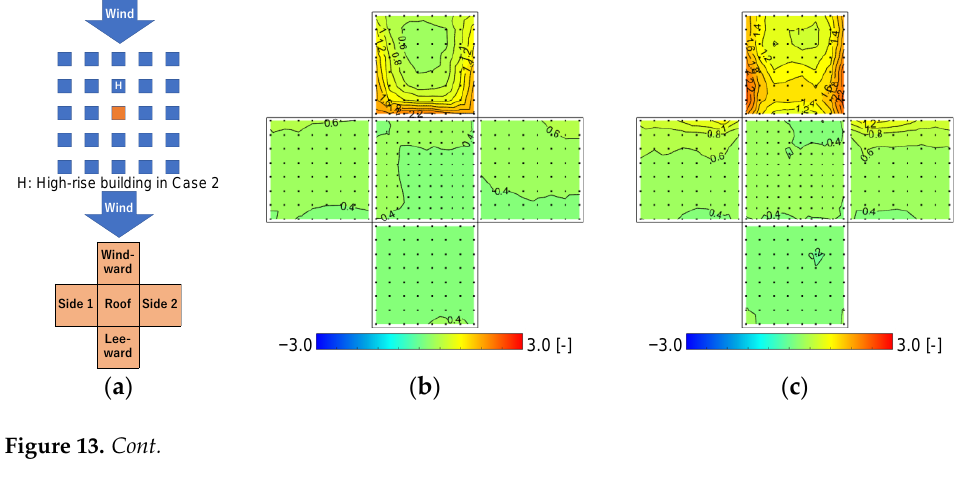
Figure 12. Mean wind pressure coefficient 𝐶 𝑝 ̅̅̅ ; ( a ) building model arrangement and prevailing wind direction for ( b , c ); ( b ) wind direction of 0° in Case 0 with no high-rise building; ( c ) wind direction of 0° in Case 2 with a high-rise building next to the pressure measurement model; ( d ) building model arrangement and prevailing wind direction for ( e , f ); ( e ) wind direction of 65° in Case 0; ( f ) wind direction of 65° in Case 2.